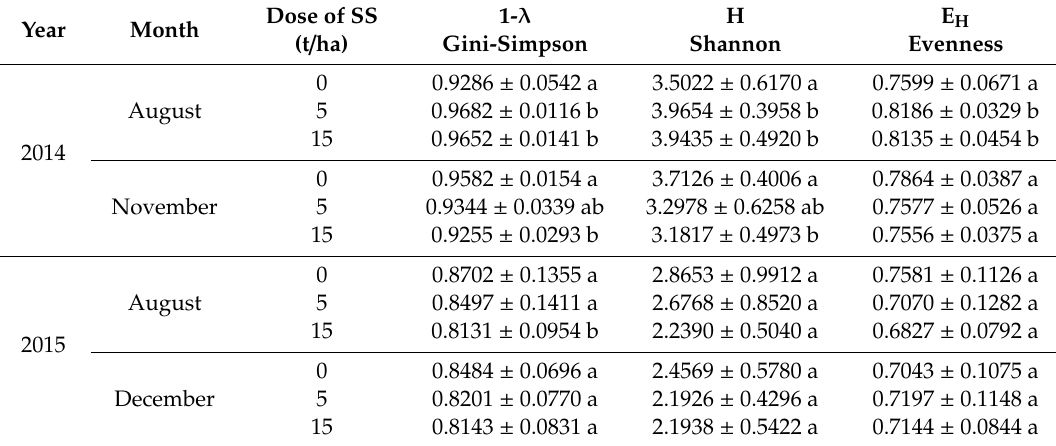
Table 2. Alpha diversity indices of fungal communities detected in the rhizosphere of Arundo donax in control and samples with sewage sludge (SS) in doses of 5 and 15 t / ha. The numbers behind the ± sign represent standard deviation (n = 12). The di ff erent letters denote statistically significant di ff erences among samples evaluated, each sampling times separately (LSD, α =